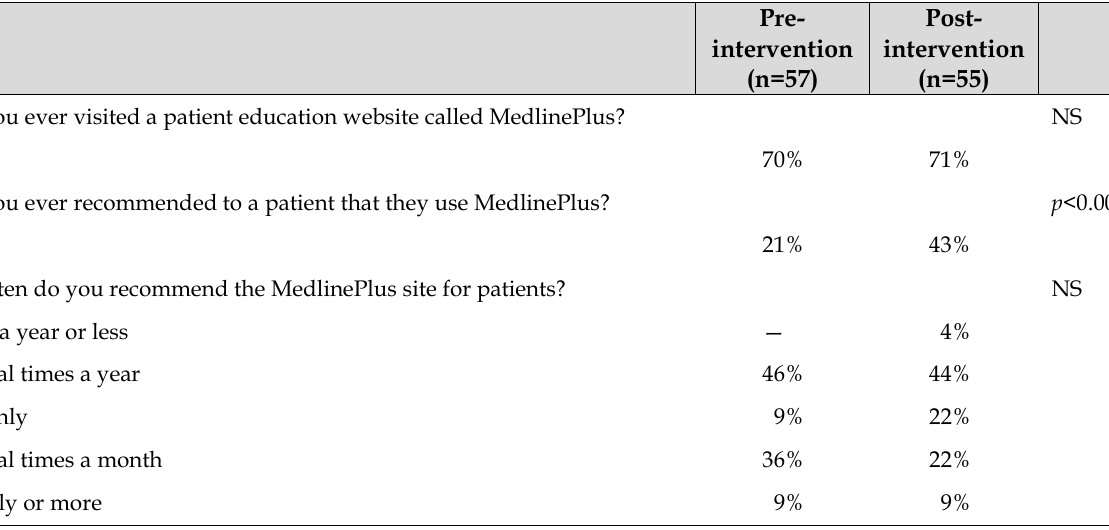
Table 5 Clinicians and nurses pre- and post-intervention survey results